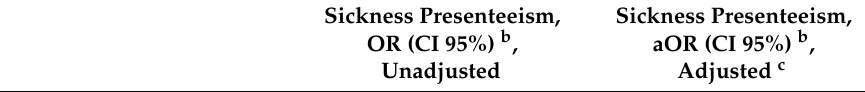
Table 2. The odds of sickness presenteeism within the previous year in association with conflicts at